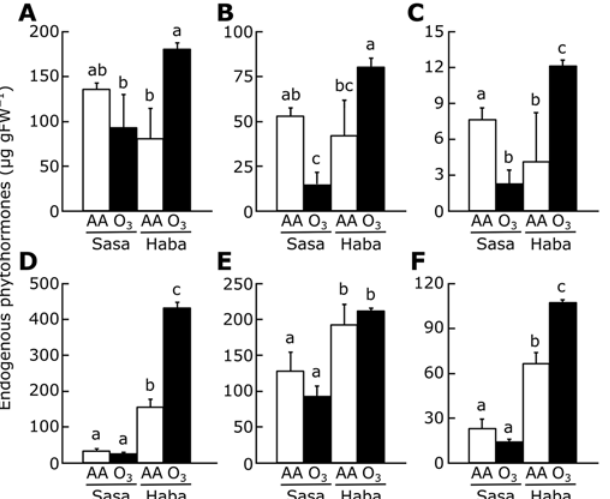
Fig 7. Ozone-induced changes in endogenous phytohormone levels in Sasanishiki and Habataki. The levels of (A, D) ABA, (B, E) JA, and (C, F) JA-Ile were measured in (A – C) inflorescence meristems and (D – F) flag leaves. Values are mean ± SD ( n = 3). AA, ambient air, O 3 , elevated ozone; Sasa, Sasanishiki; Haba, Habataki. Bars topped by the same letters are not significantly different (Tukey ’ s HSD test, P <